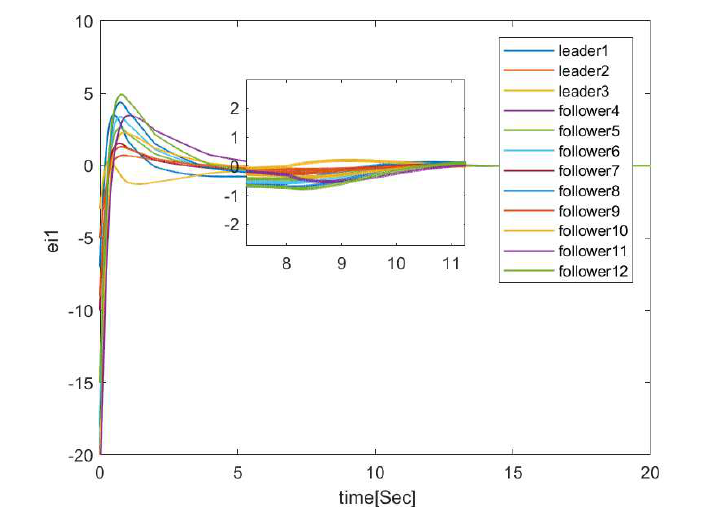
Figure 1. Topology of the hierarchical multi-agent network with uncoupled follower groups.